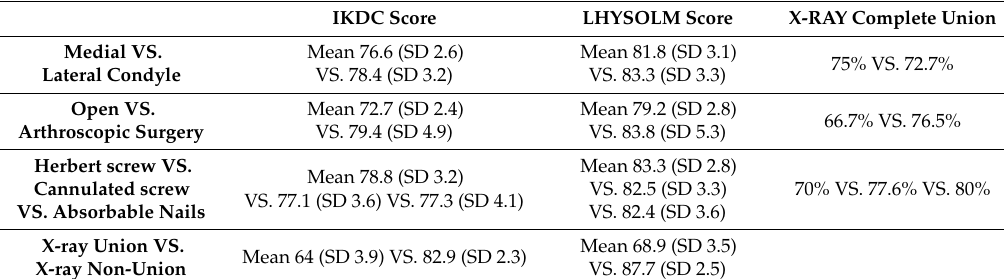
Table 2. Numerical